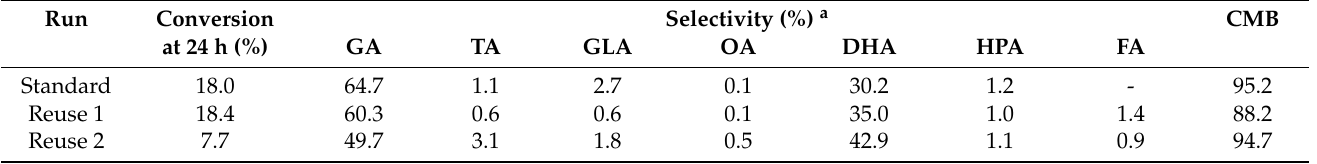
Table 7. Reuse data for base-free glycerol oxidation (24 h, 60 °C, substrate/metal ratio of 2728:1).